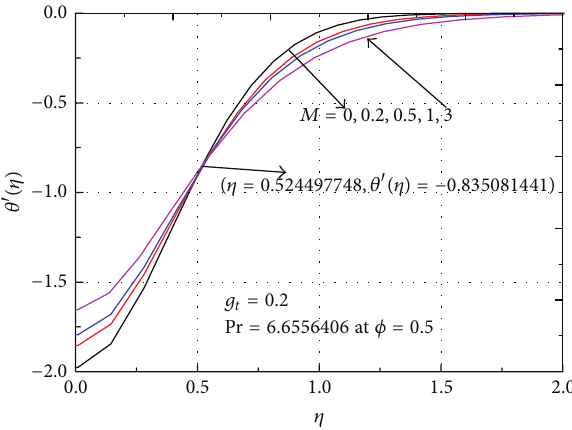
Figure 3: Effect of magnetic parameter on shear stress.